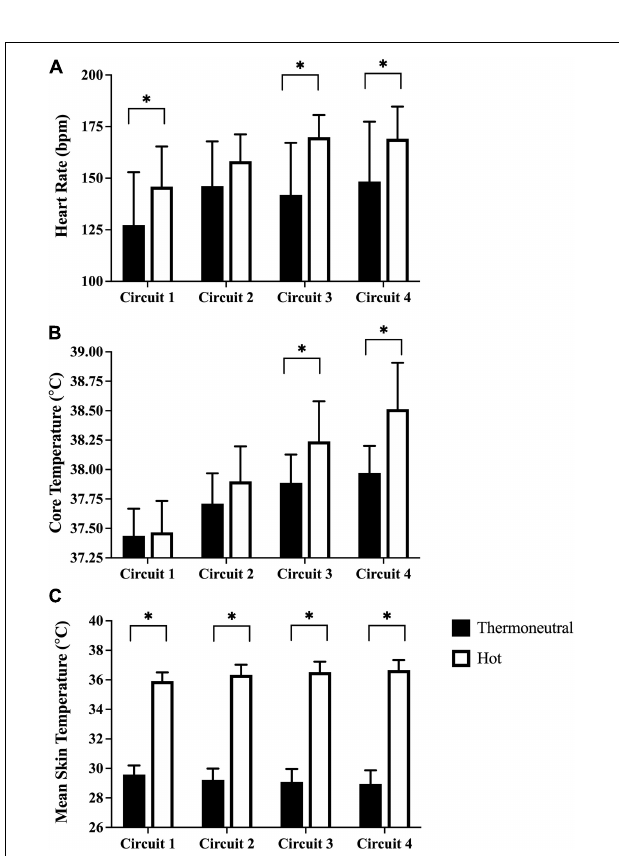
FIGURE 2 | Heart rate (top), core body temperature (middle), and mean skin temperature (bottom) in the temperate and hot conditions at the end of each round of work. Data presented as mean ± SD. ∗ Values are different ( p < 0.05) at the beginning and end of the